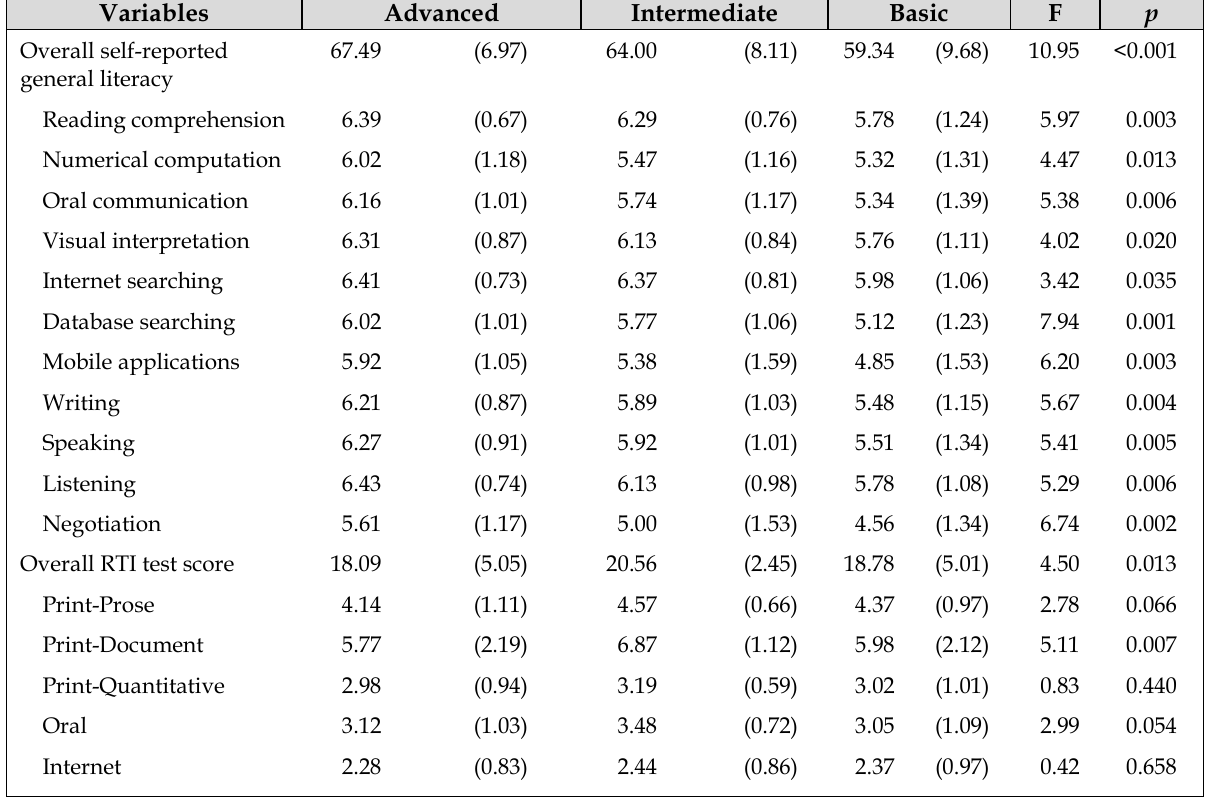
Table 4 Self-reported and Research Triangle Initiative (RTI) health literacy test